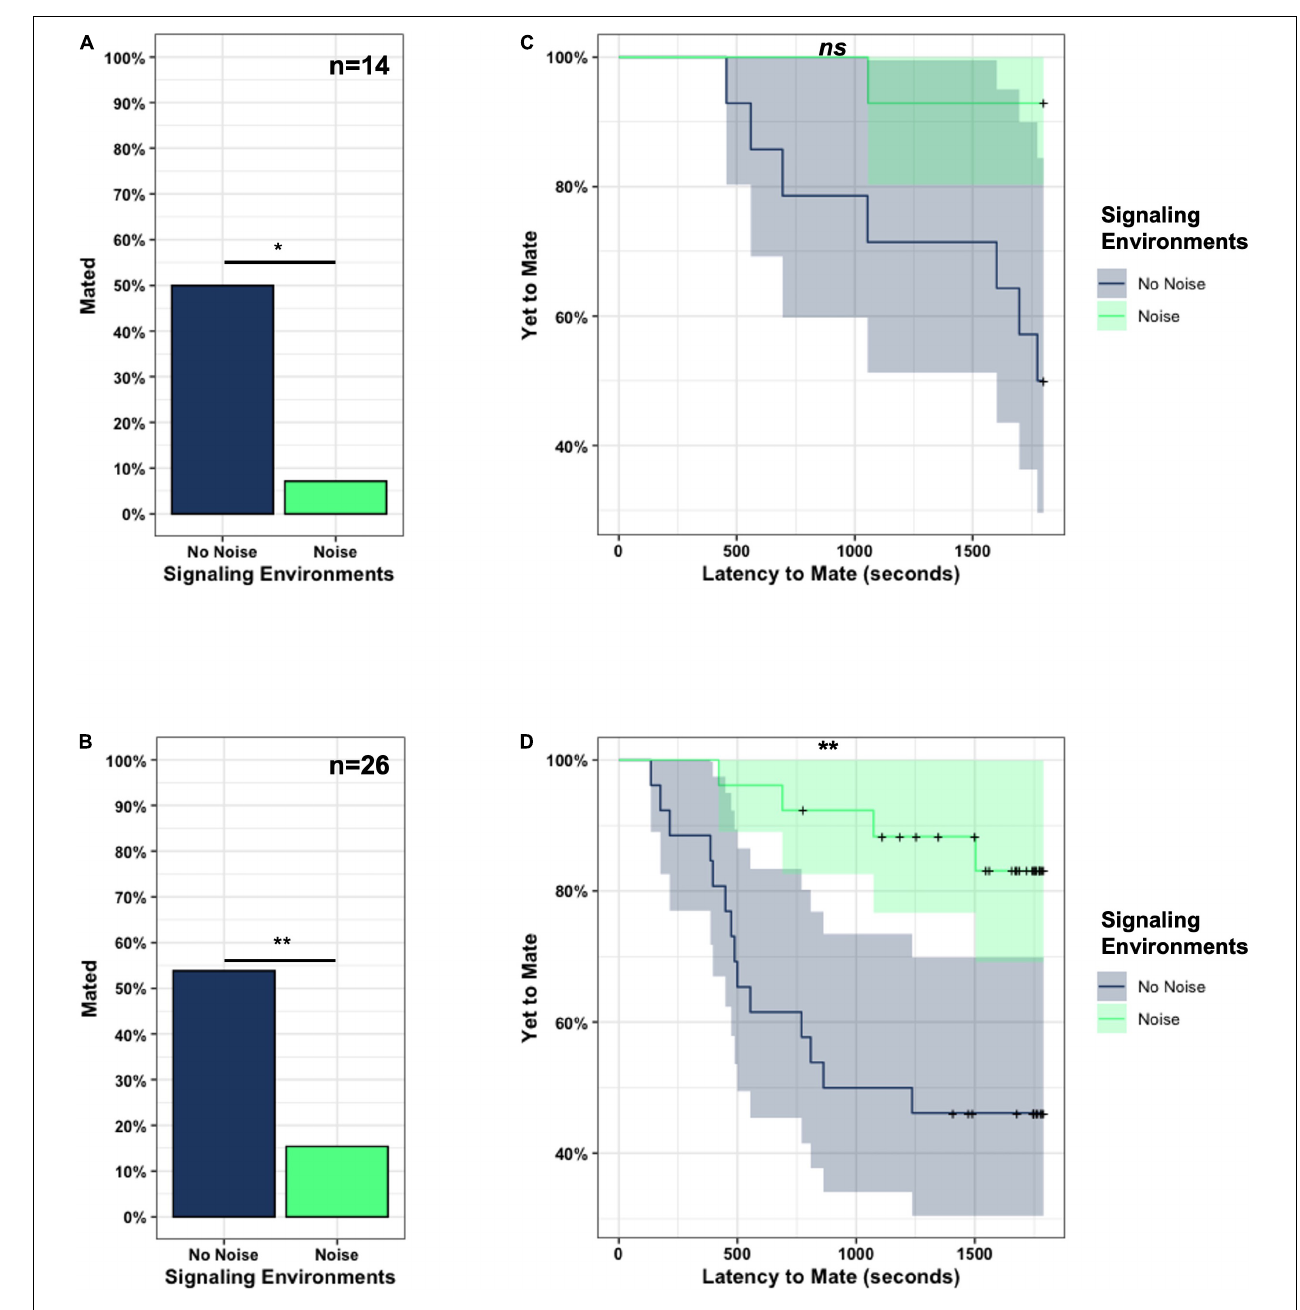
FIGURE 2 | Mating success was higher and faster in the No Noise compared to the Noise signaling environments. In both Experiment 1 ( A , * p < 0.05) and Experiment 2 ( B , ** p < 0.01) more pairs mated in the No Noise than in the Noise signaling environments. In Experiment 1 (C) , pairs that mated also tended to do so faster in the No Noise compared to the Noise signaling environments ( p = 0.07: Here, ns-not significant), but the sample size was low, with only 1 mating in Noise. In Experiment 2 (D) pairs that mated did so significantly faster in the No Noise than in the Noise signaling environments (** p < 0.01). The shaded regions in the Kaplan Meier survival analysis (C,D) are the 95% confidence intervals at each time point and “ + ” signs (often superimposed) indicate pairs that did not mate (censored pairs).